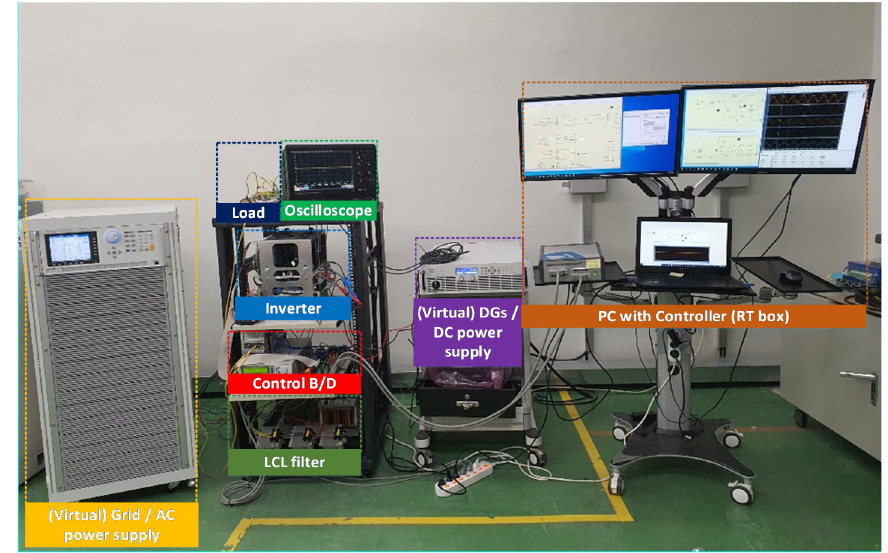
Figure 11. GCI experimental set-up for EV’s application.